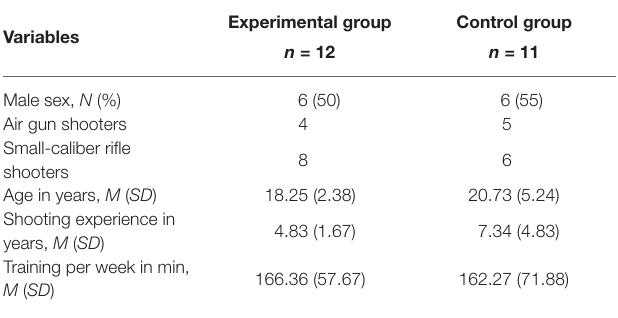
TABLE 1 | Descriptive statistics for both